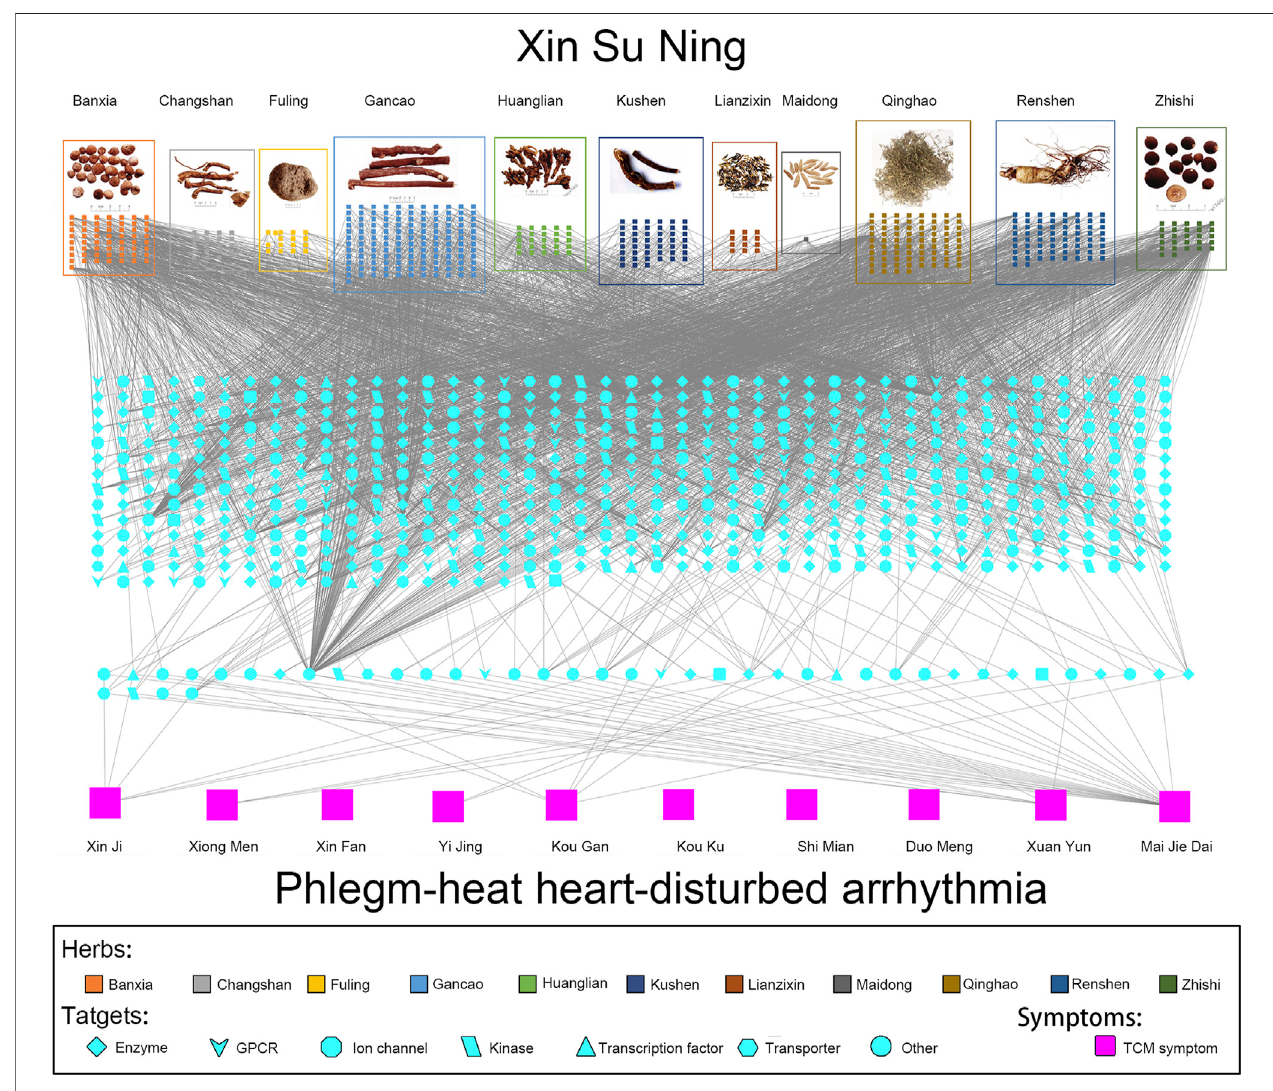
FIGURE 5 | Panoramagram of the pharmacological mechanism of XSN for treating PHHD arrhythmia. (A) 11 herbs that formulated XSN are shown in the box with differentcolors, and thecomponentsofeach herbare shown insmall squares withthesame color astheirsource herb. (B) Target spectrum ofXSN. Allthe targets were corresponding to the component in panel A; the 41 targets showed in the dash line box in the bottom are the overlapping target set between the XSN target spectrum and the PHHD-arrhythmia target spectrum. Targets were shown in different shapes according to the classi fi cations as indicated in the keys. (C) Arrhythmia with Zheng and relative TCM symptoms. Ten TCM symptoms of PHHD arrhythmia were represented by large pink squares in the bottom panel (Wang et al., 2019b).